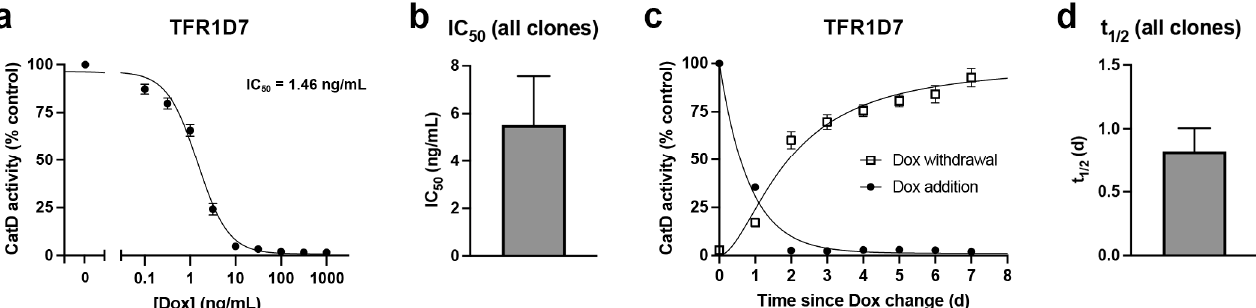
Figure 3. Detailed functional characterization of Dox-mediated downregulation of CatD activity made possible by the TRE-Lox system. ( a ) CatD activity as a function of Dox concentration in the TFR1D7 stable cell line. Cells were treated for 4 d with the indicated concentrations of Dox. The calculated IC 50 is indicated. Note that for all Dox concentrations above 100 ng/mL, CatD activity is essentially completely abrogated. ( b ) IC 50 values for three separate stable clones (see Supplementary Materials Figure S7). ( c ) Time course of CatD activity following addition or withdrawal of Dox (100 ng/mL) in TFR1D7 cells incubated for 7 d prior in the absence or presence of Dox (100 ng/mL), respectively. Data are mean ± SEM; n = 3. ( d ) Average half-life (t 1/2 ) of the reduction in CatD activity after addition of Dox (100 ng/mL) to three separate stable clones (see Supplementary Materials Figure S8). Data are mean ± SEM; n = 3. Effects on CatD protein levels are shown in Supplementary Materials Figure S10.